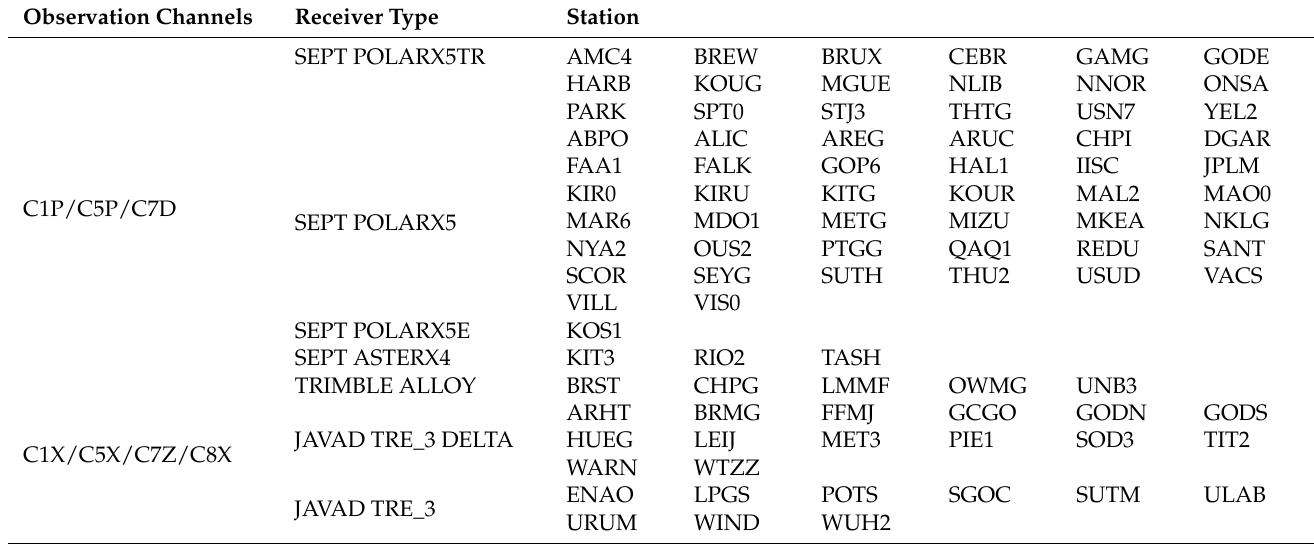
Table 4. Station and receiver information for BDS-3 DCB